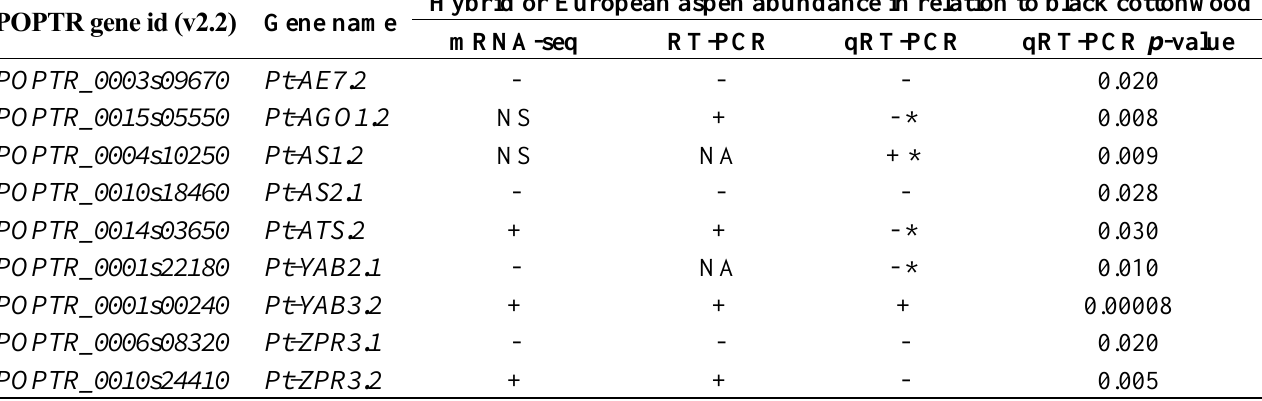
and hybrid aspen/European aspen leaf blades according to transcriptome sequencing (mRNA-seq), RT-PCR, and qRT-PCR (with p -value presented for qRT-PCR) results. Hybrid or European aspen abundance in relation to black cottonwood mRNA-seq RT-PCR